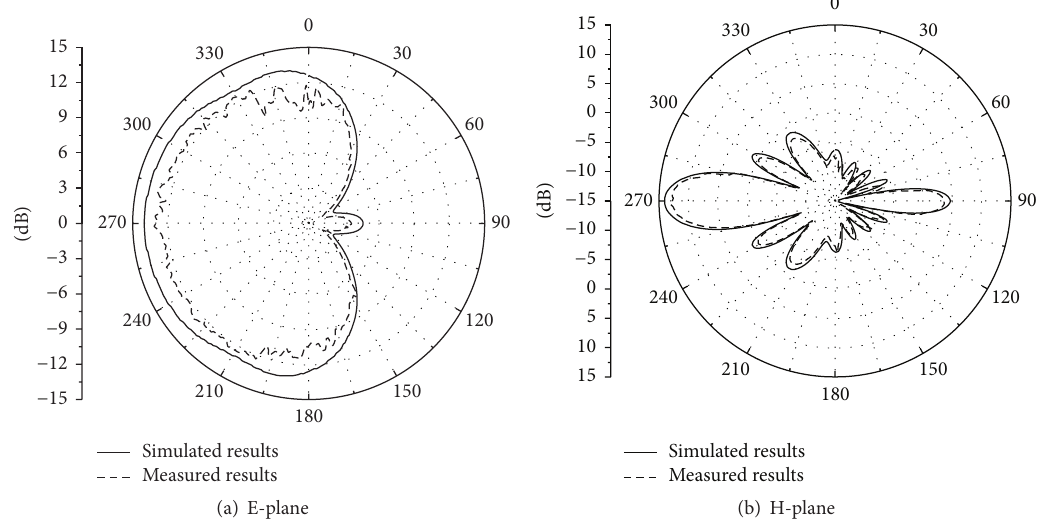
Figure 24: Pattern of the SIW Vivaldi antenna array on 9.5 GHz.